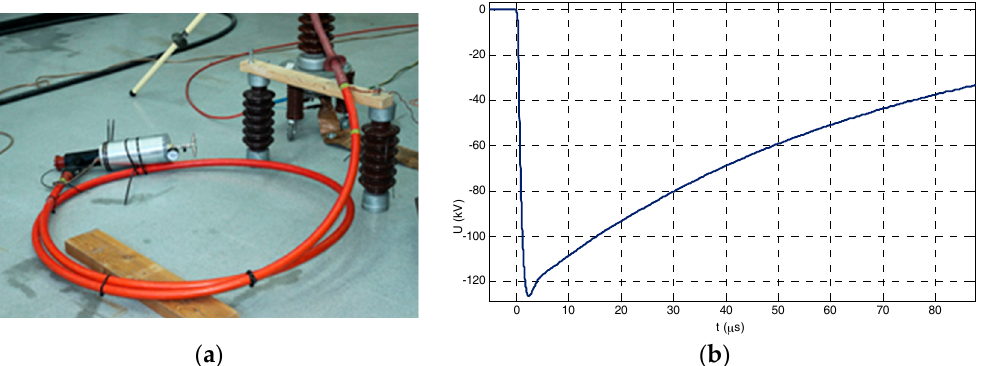
Figure 12. ( a ) Testing layout of the voltage divider prototype connected to a medium voltage cable, ( b ) negative lightning impulse (125 kV) applied during the withstand test.